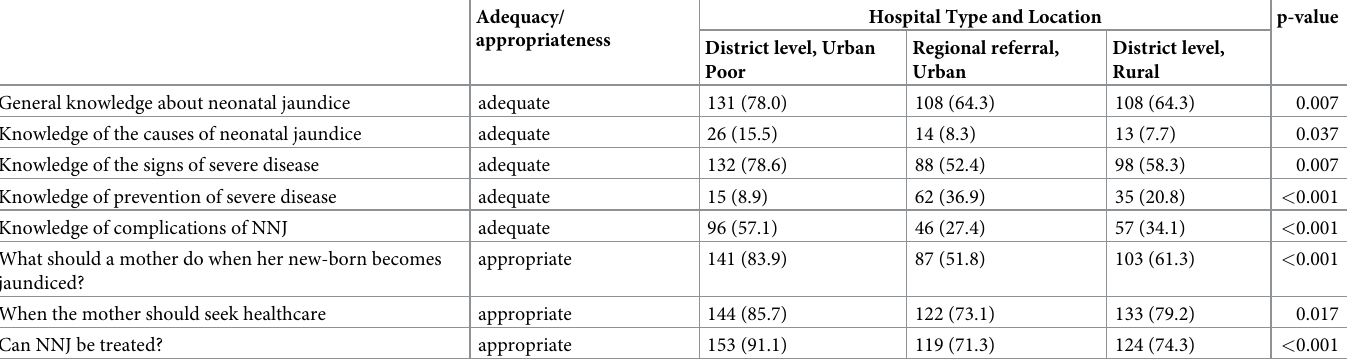
Table 7. Differences in knowledge, attitude, and perceptions of mothers towards neonatal jaundice by health facilities